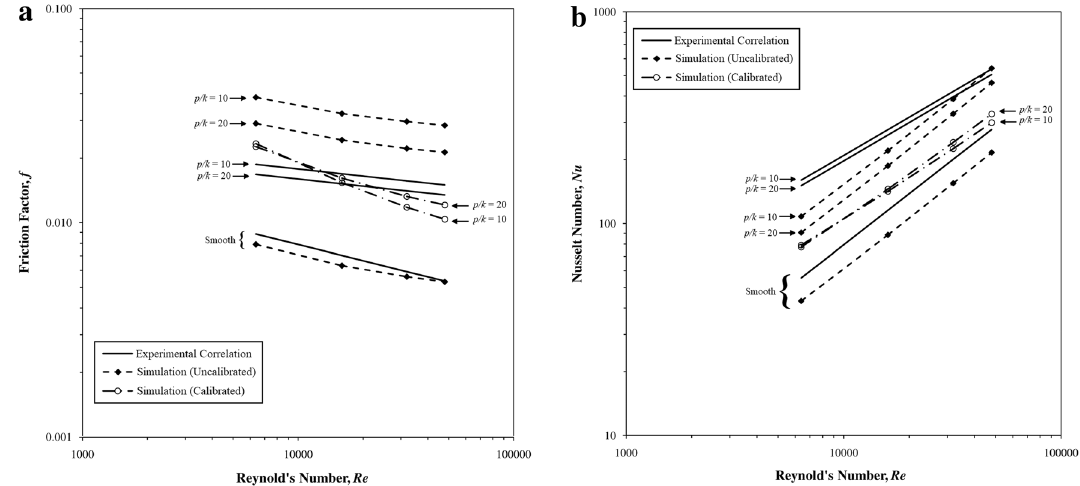
Fig. 14 Comparison of simulated friction factors with experimental correlations for channel height, H = 3.2 mm, b Comparison of simulated Nusselt numbers with experimental correlations for channel height, H = 3.2 mm